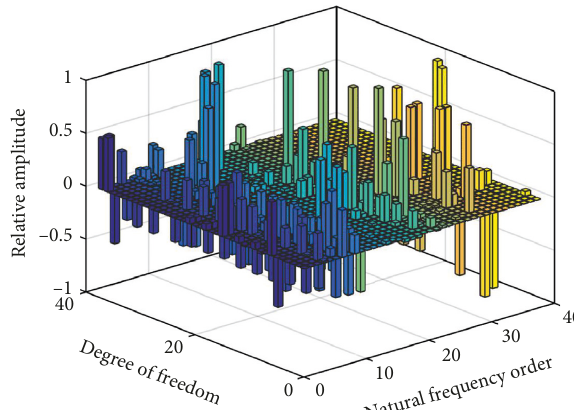
Figure 9: Vibration modes of EMS hoist system.